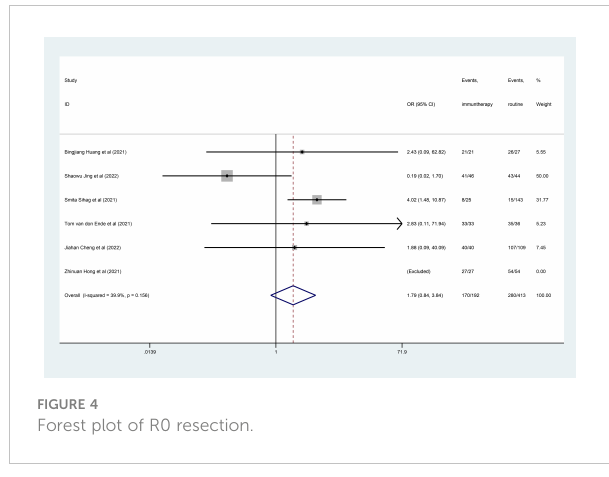
FIGURE 4 Forest plot of R0 resection.